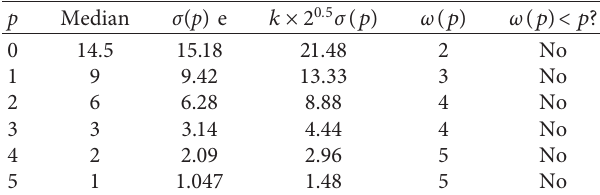
Table 14: step estimations for the investigation with the edge plan.